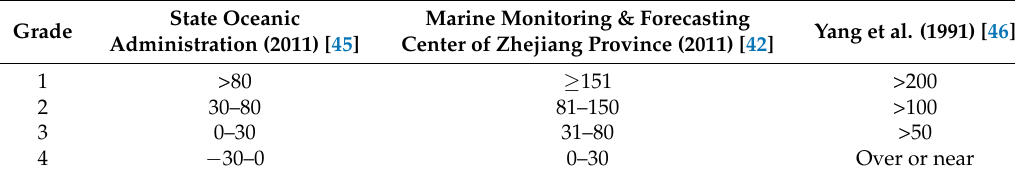
Table 2. Storm surge disaster intensity division based on the hypervigilance tide level (unit: cm).